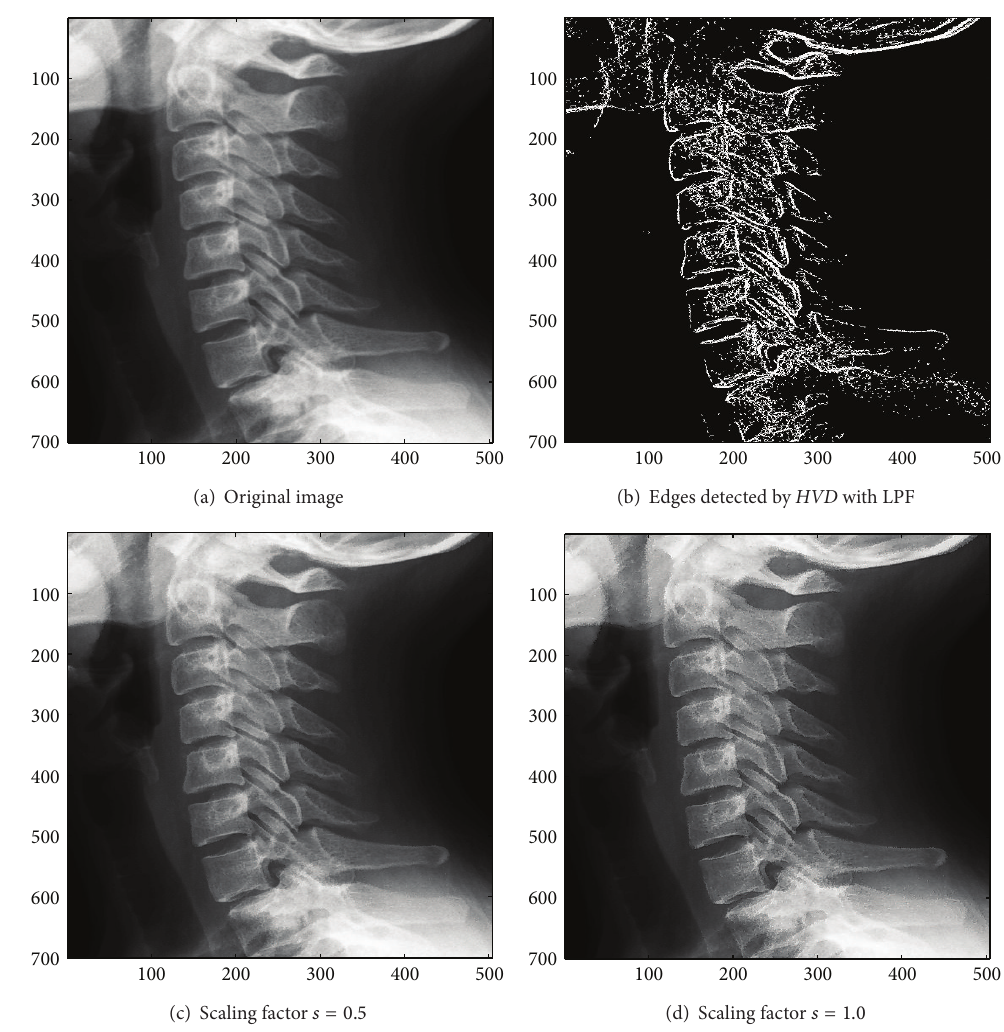
= 7 for HVD . (a) The image “Neck” (504 × 700 grey image). (b) Edges detected by HVD with LPF. (c and d) Sharpened results Figure 14: 𝜃 eth by HVD with scaling factors 0.5 and 1.0 ,